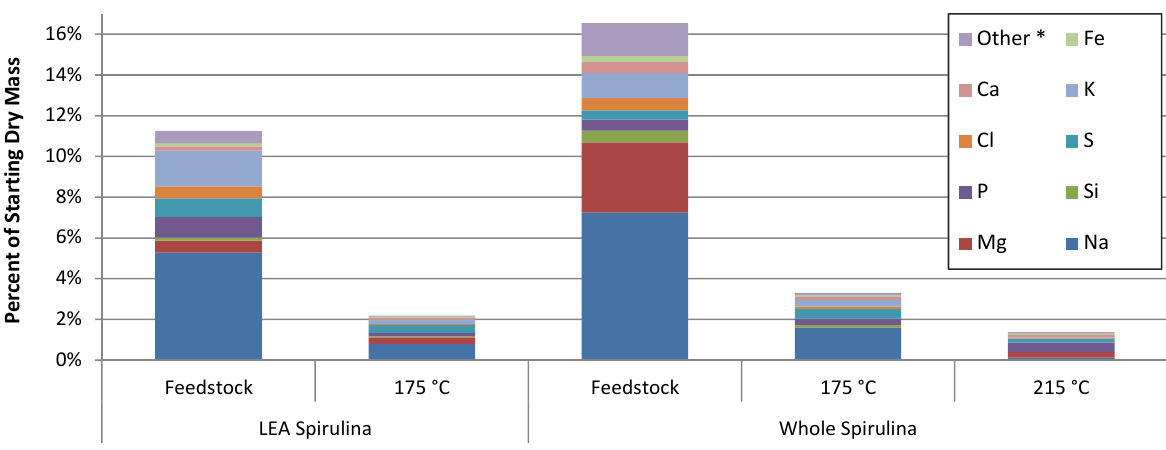
Figure 4. Results of inorganic elemental analysis by X-ray fluorescence (XRF) of feedstocks and hydrochars, expressed as a percentage of starting dry mass (not including C, H, N, and